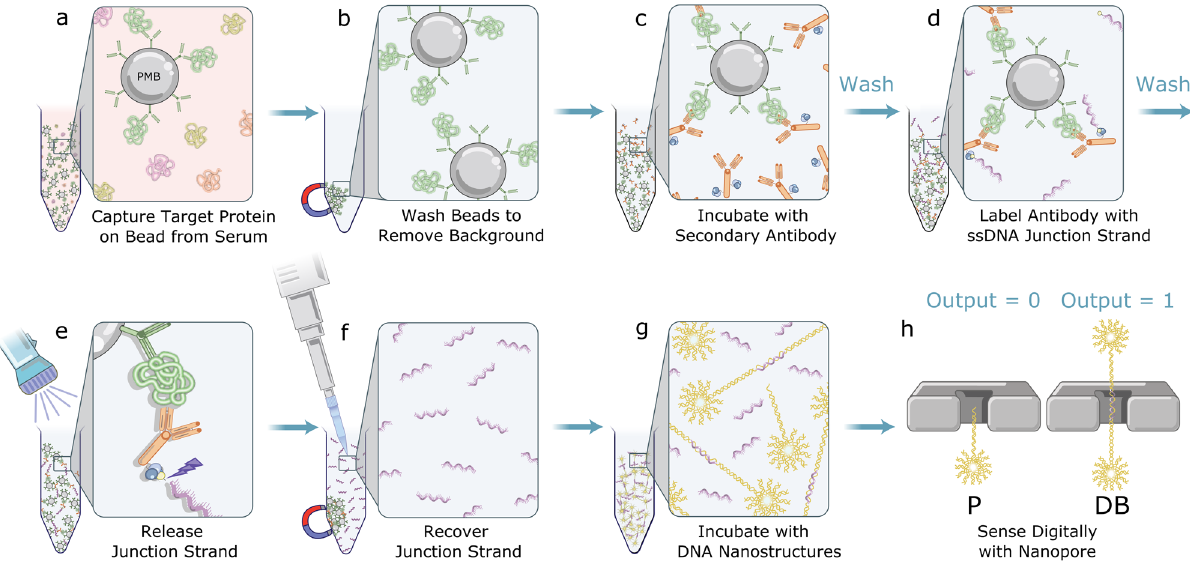
Fig. 1 Schematic illustration of the digital immunoassay work fl ow with nanopore electrical detection. a Paramagnetic beads (PMBs) conjugated with antibodies ef fi ciently capture speci fi c target protein in serum sample. b PMBs are pelleted and immobilized with a magnet and supernatant is removed to eliminate unbound molecules. c PMBs are resuspended and incubated with secondary antibody conjugated with streptavidin. d Following a wash, the immuno-sandwich structure is incubated with biotinylated ssDNA junction strand. e Following another wash, the solution is exposed to UV light to release the junction strand. f PMBs are pelleted and immobilized with a magnet and the supernatant containing the junction strand is recovered with a pipette. g Shooting star-like DNA probes are added to the solution containing recovered junction strand leading to assembly of a dumbbell-like DNA nanostructure. h Digital nanopore sensing to determine the fraction of probes to